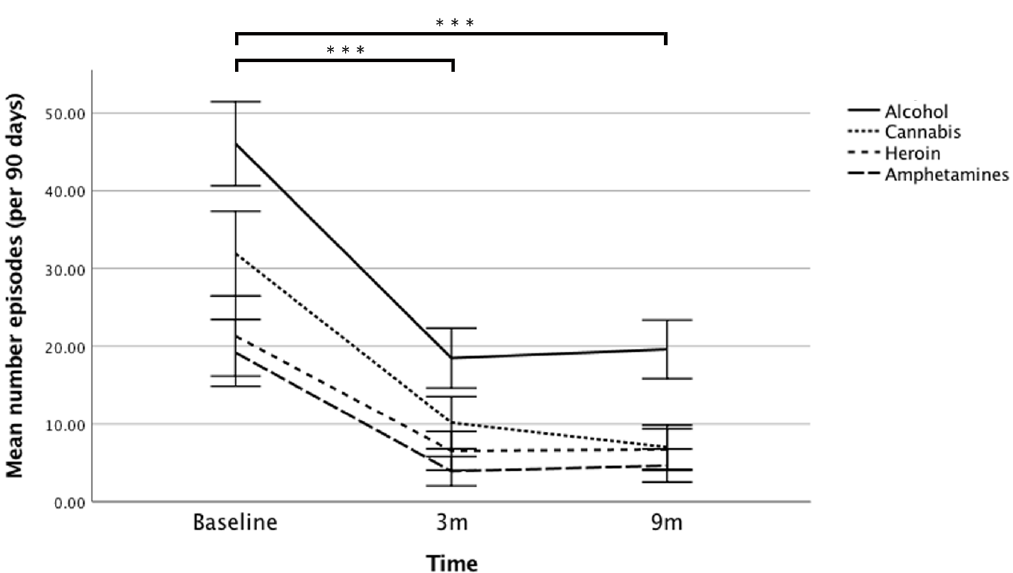
Figure 1. Mean number of episodes, separated by substance type (alcohol, cannabis, heroin, and amphetamine), at baseline, 3 months (3m) follow-up, and 9 months (9m) follow-up. Error bars = 95% Confidence Interval (CI) of mean, *** p < 0.001 for each of the four drug types, See Table S1 in Supplementary Materials for detailed statistics.